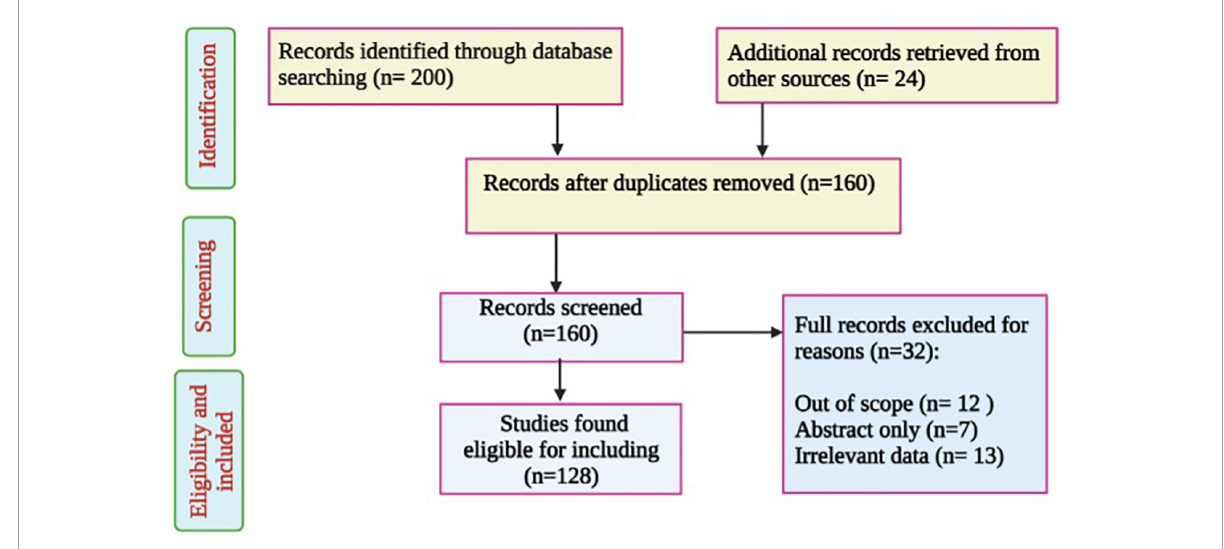
FIGURE1 Flowchart of Piper cubeba studies inclusion and exclusion criteria.